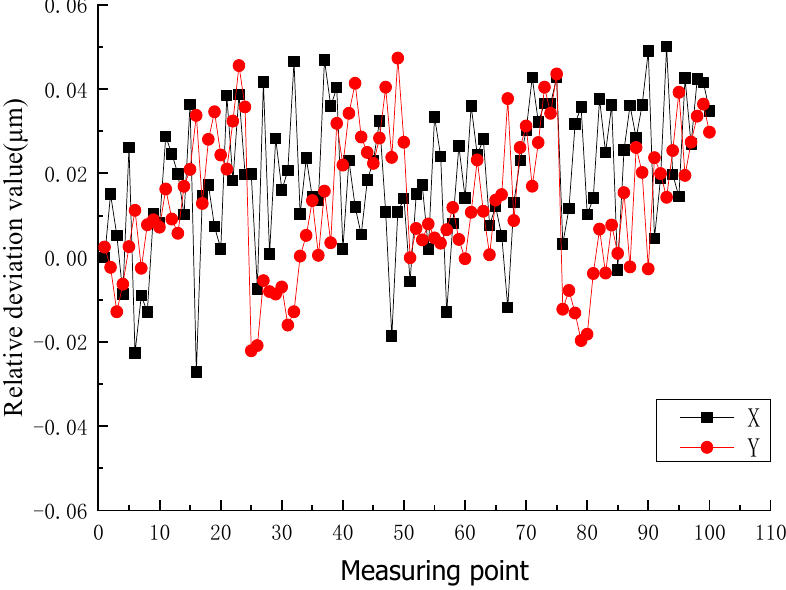
Figure 9. Stability of the spot position detection.